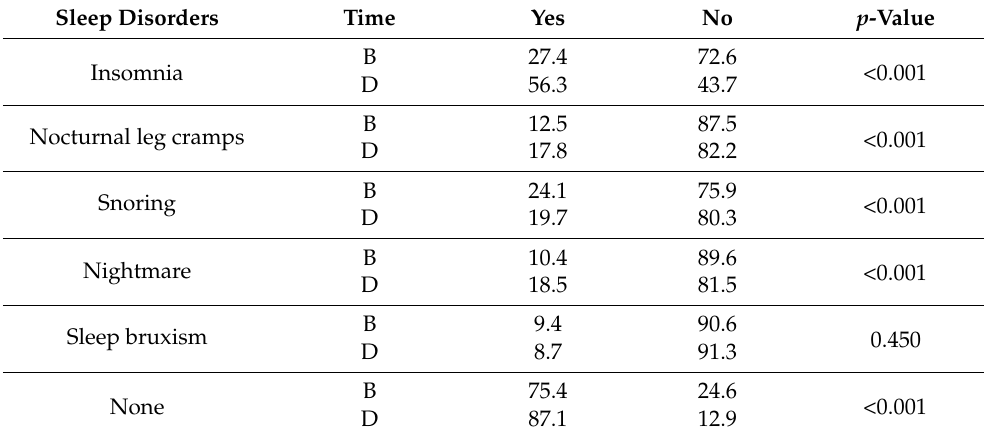
Table 2. Sleep disorders before and during COVID-19 lockdown (%).